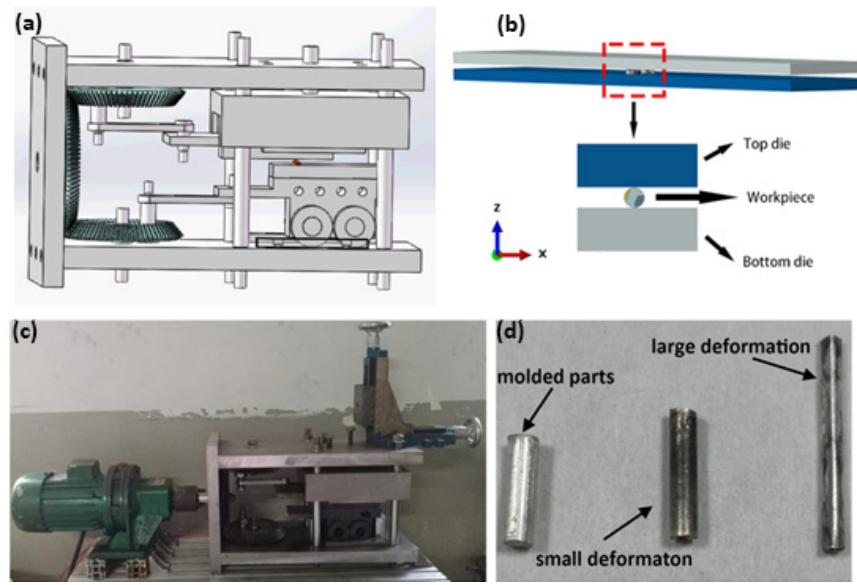
Figure 2. Thread rolling model: ( a , b ) drawing; ( c , d ) experiment.